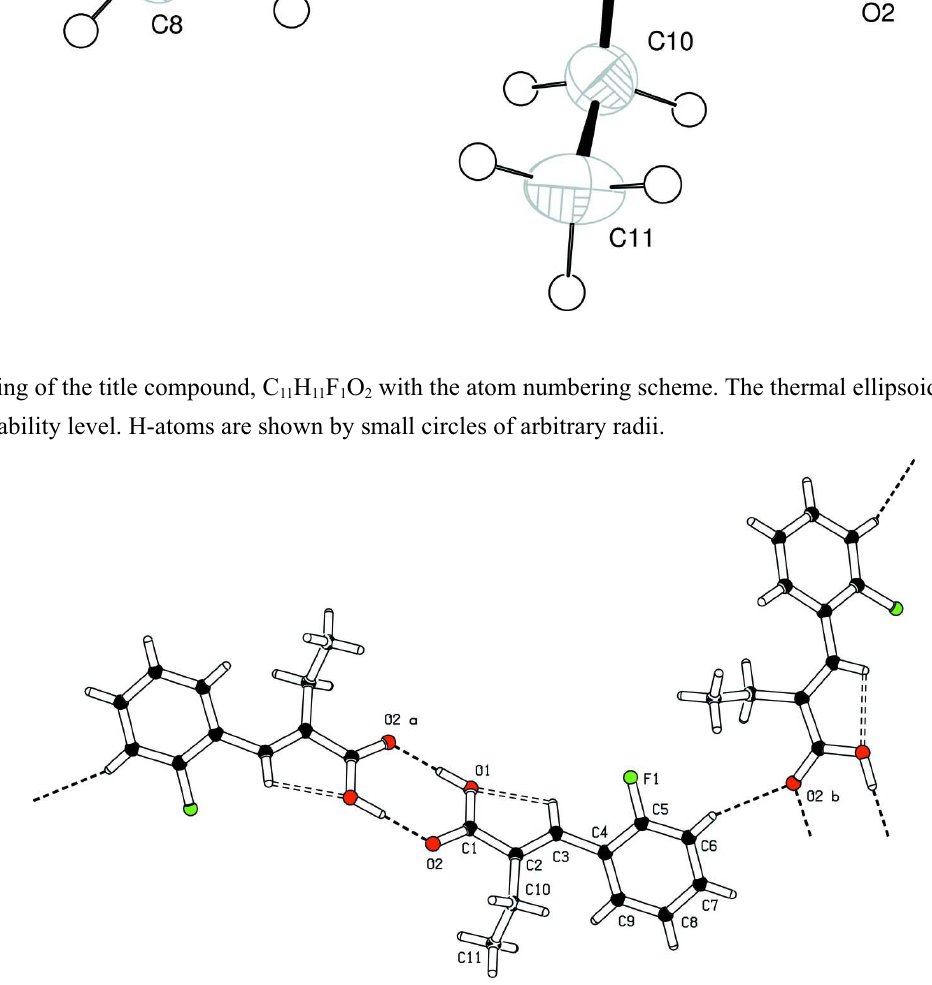
The packing figure ( PLATON : Spek, 2003) which shows the dimeric nature of the compound owing to inter molecular hydrogen bonding and also showing a link between